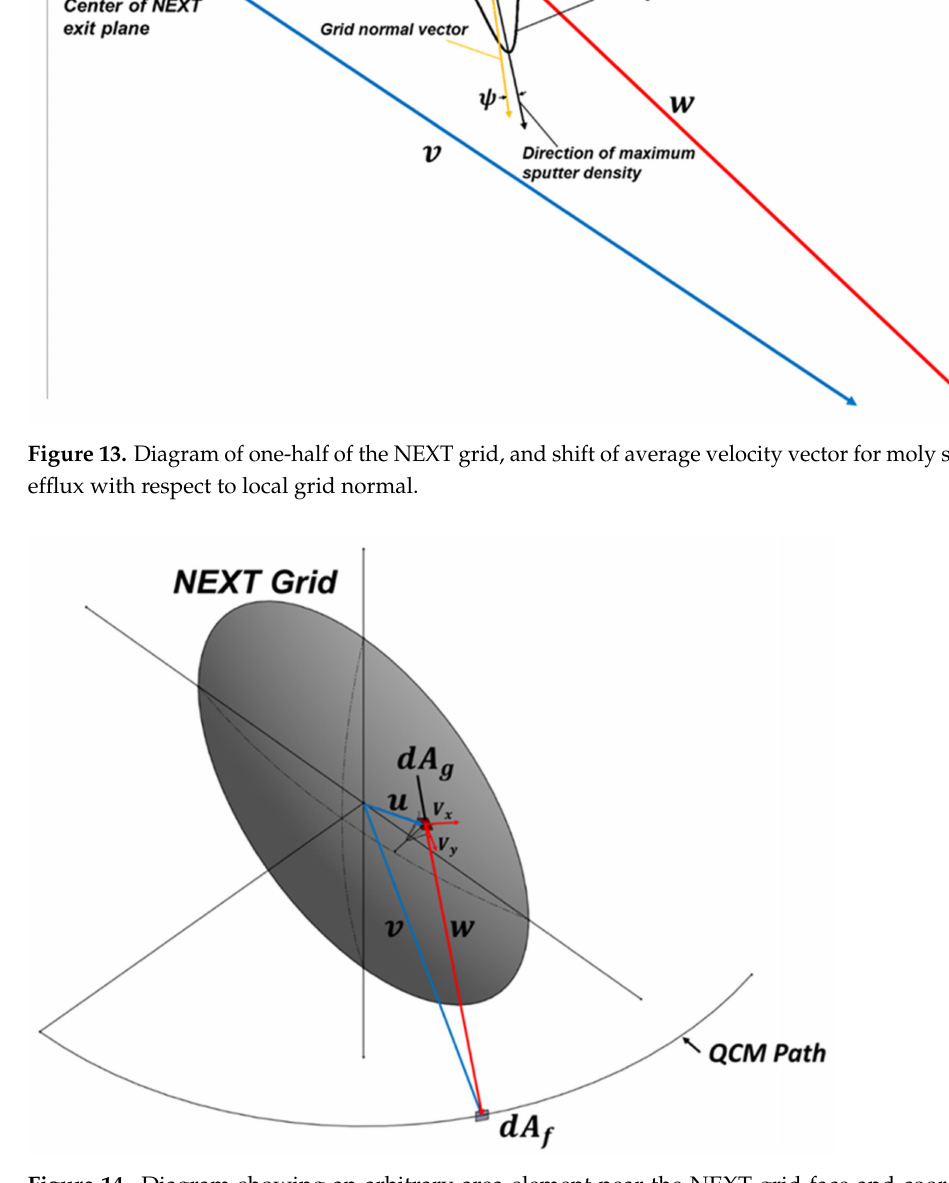
Figure 14. Diagram showing an arbitrary area element near the NEXT grid face and coordinate system for analyzing its contribution at an arbitrary location along an arc 1 m from